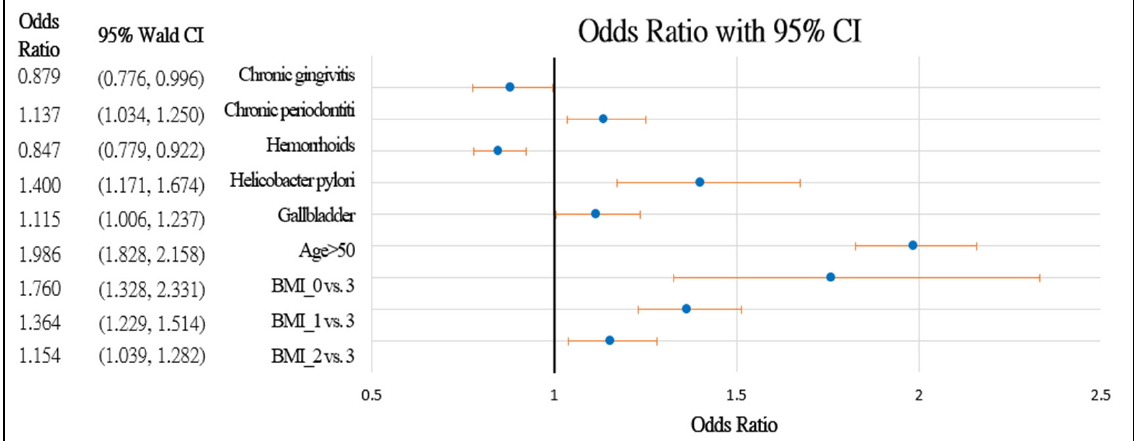
Figure 2. Forest chart of colorectal polyps’ risk factors in female patients. Underweight = 0, normal = 1, overweight = 2, and obesity = 3.